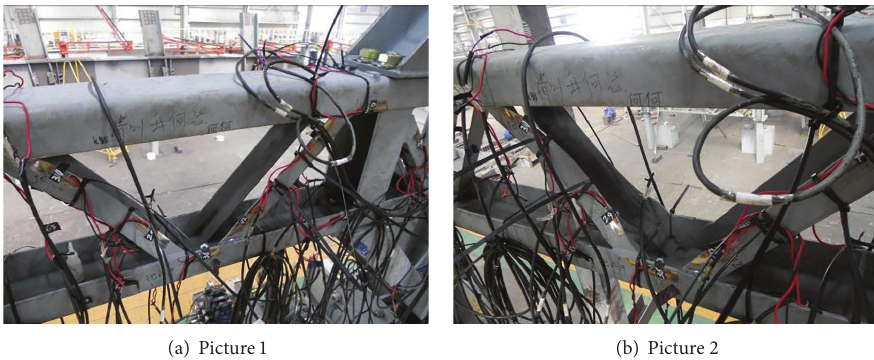
Figure 22: Failure mode under ultimate load.